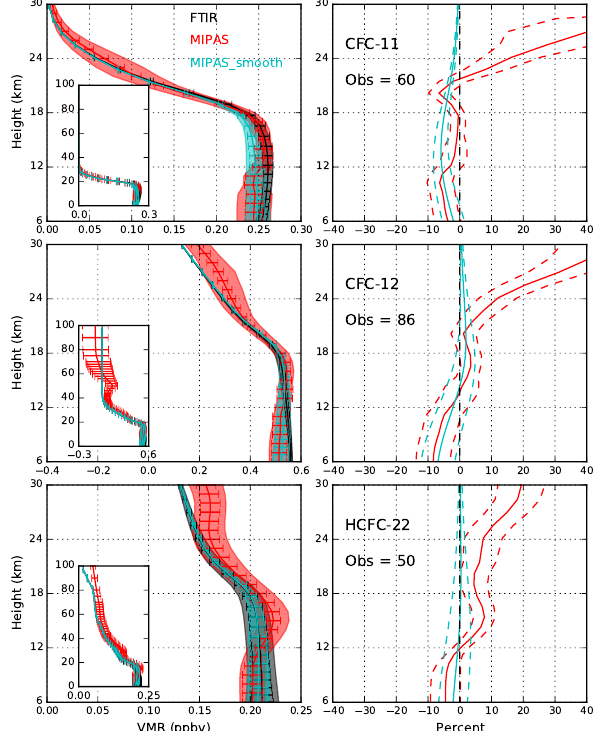
Figure 6. Left panel, for each target species (from top to bottom: CFC-11, CFC-12 and HCFC-22): averaged target species mixing ratio profile, random uncertainty (error bar) and the standard de- viation of all the co-existing data pairs (shade area) for FTIR (in black) and for MIPAS (in red: raw data; in sky blue: after smooth- ing with the corresponding FTIR averaging kernel). The profiles (from 0 to 100km) are also manifested in the left panels. Right panel, for each target species, averaged relative difference between MIPAS and FTIR ((MIPAS − FTIR) / FTIR × 100%) (solid lines), along with the standard deviation (dash lines).